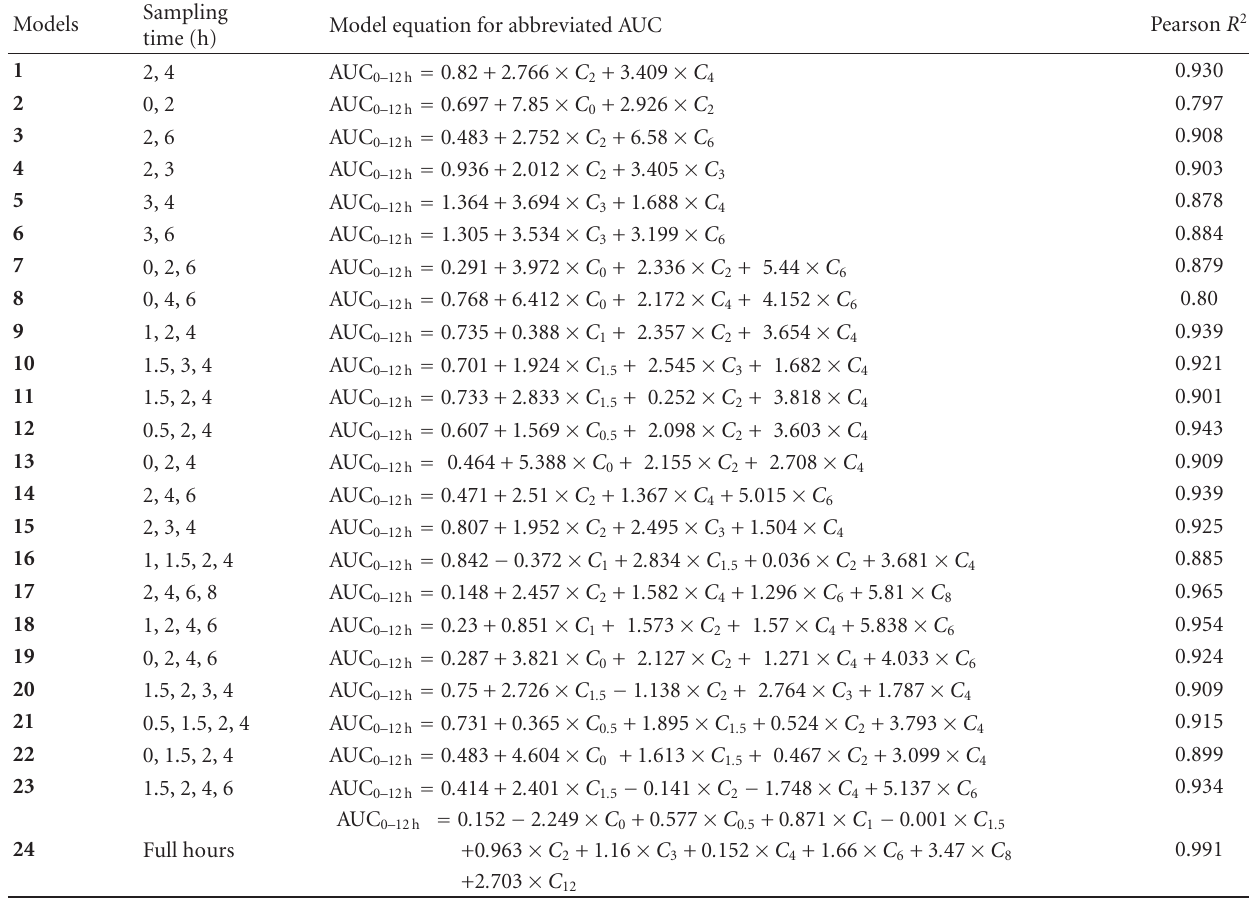
Table 4: Multiple linear regression analysis of the correlation between the estimated cyclosporine (CsA) AUC 0–12h and full hours CsA AUC ( N =